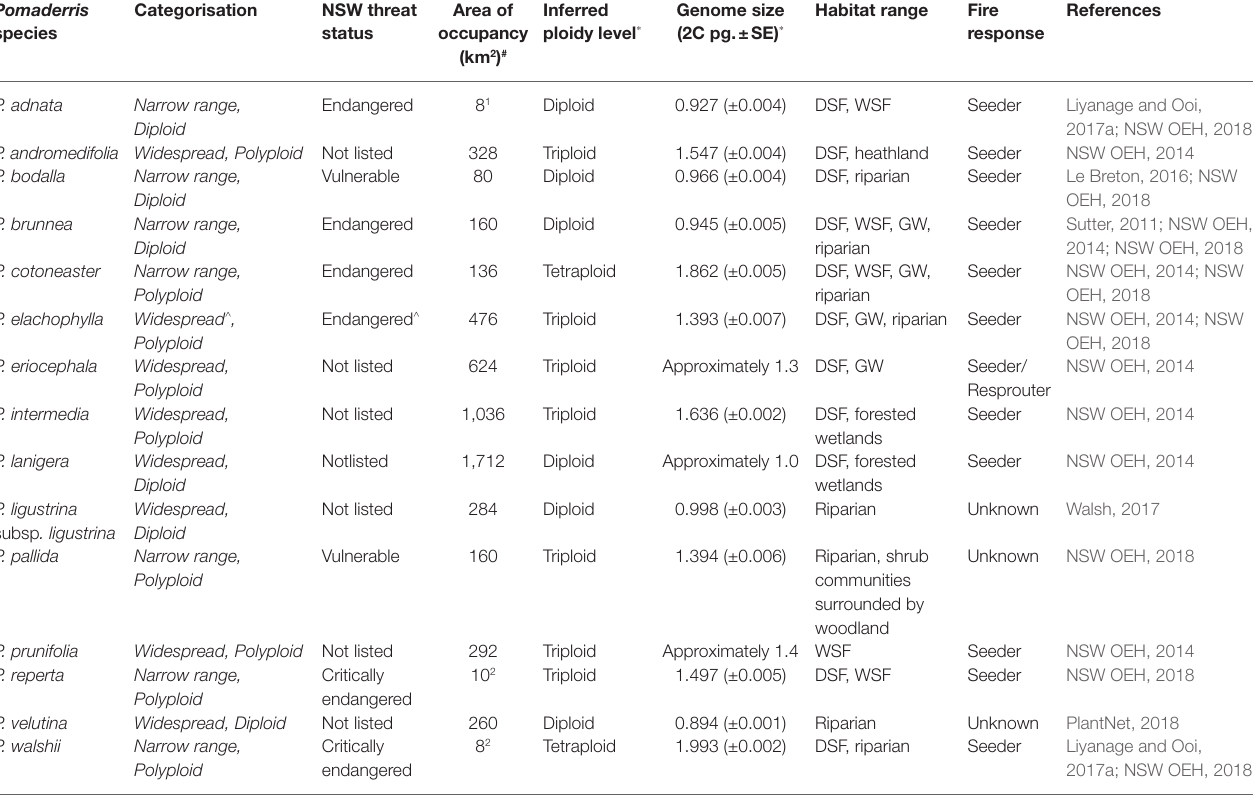
TABLE 1 | List of Pomaderris species selected for this study, including information on their State (NSW) threat level, range size (area of occupancy (AOO)), ploidy, genome size, habitat and fire response. Pomaderris